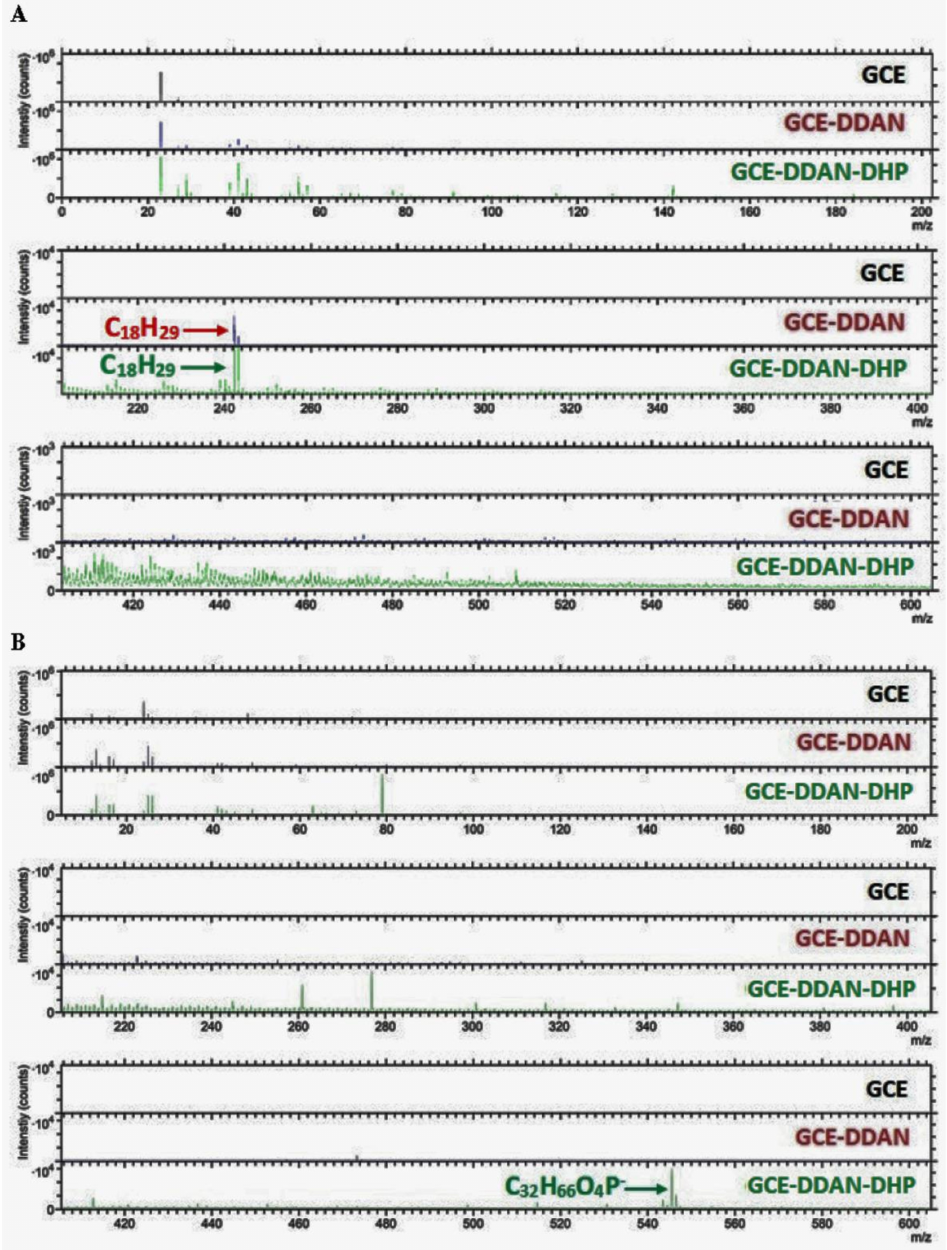
Figure 3. ToF-SIMS spectra for all three surfaces (500 × 500 µ m 2 area): bare glassy carbon electrode (GCE), the first layer-modified electrode (GCE-DDAN) and bilayer-modified electrode (GCE-DDAN- DHP) at negative ( A ) and positive ( B )